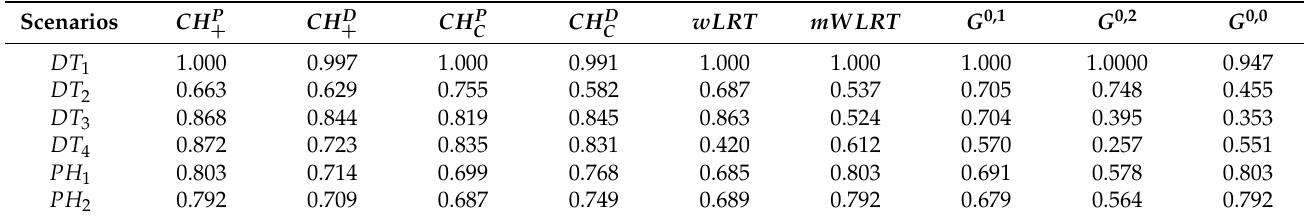
Table 4. Empirical power in simple